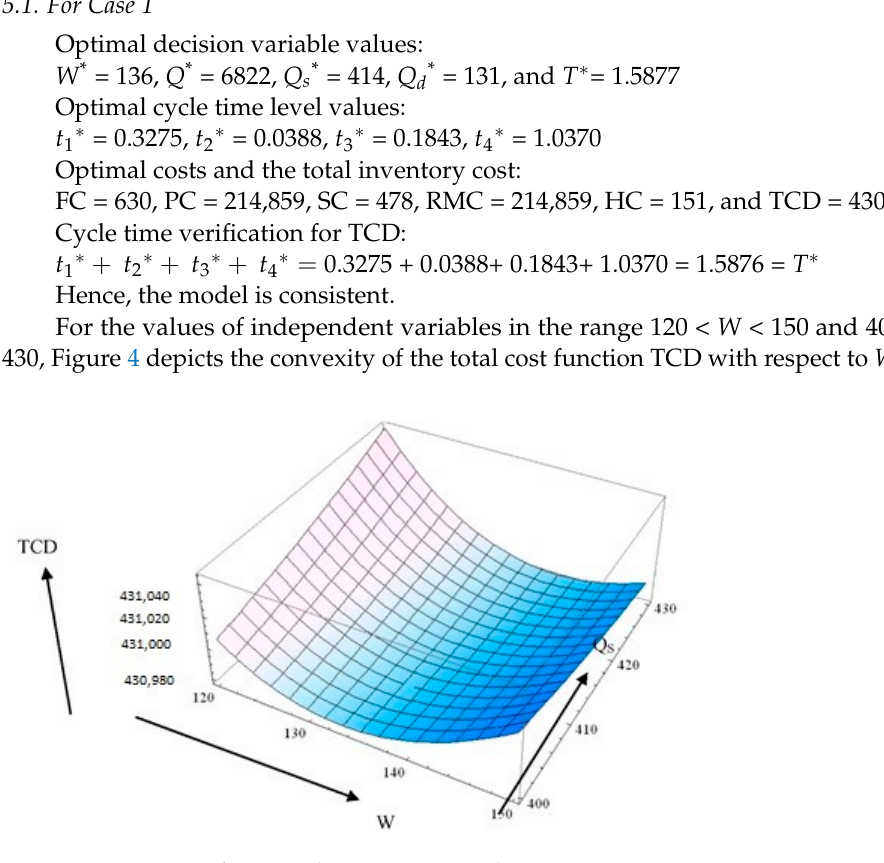
Figure 5. TCD vs. W graph. Fixing W = 136 and 250 < Q s < 350, the following Figure 6 shows that TCD is convex with respect to Q s , and the total inventory cost reaches minimum at “ Q s = 414”.